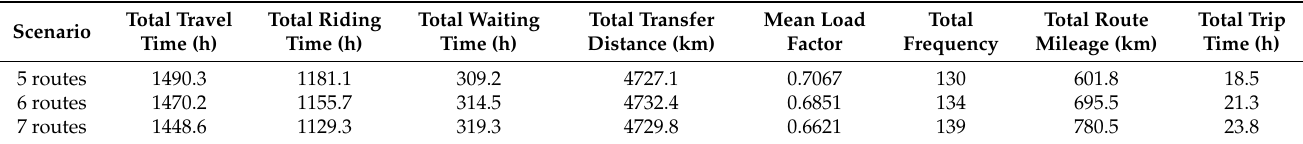
Table 6. Effect of the number of routes on the proposed model performance.